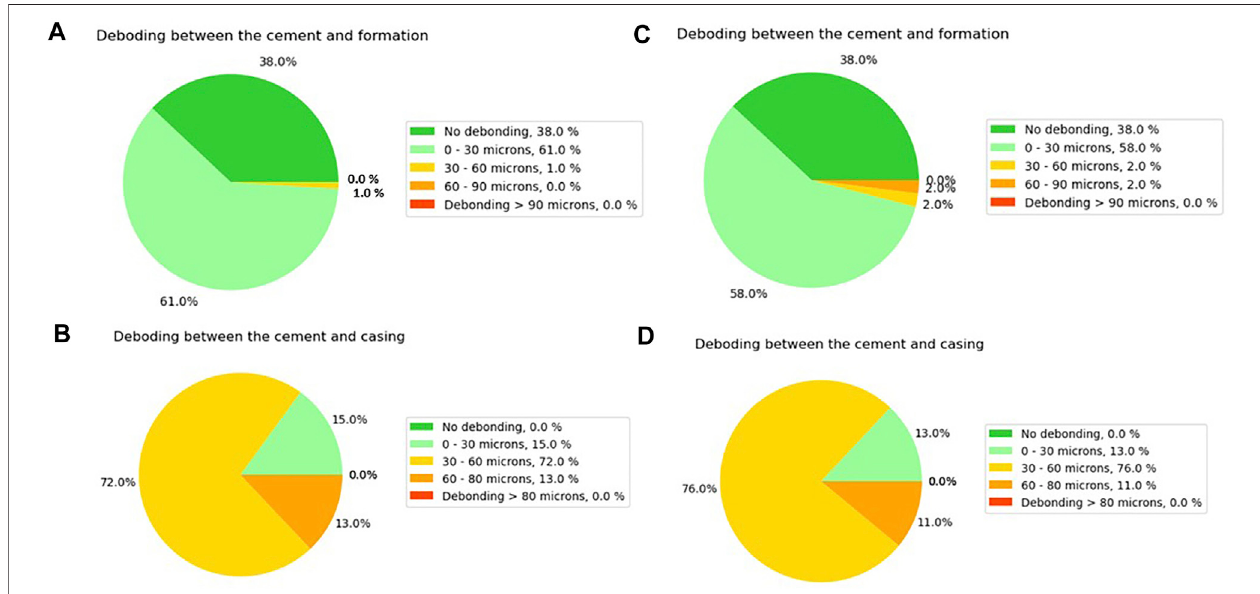
FIGURE 11 | Results of cement integrity prediction for (A) debonding between the cement and the formation and (B) debonding between the cement and casing for a depth of 709 m. (C) Debonding between the cement and the formation and (D) debonding between the cement and casing for a depth of 1,206 m.